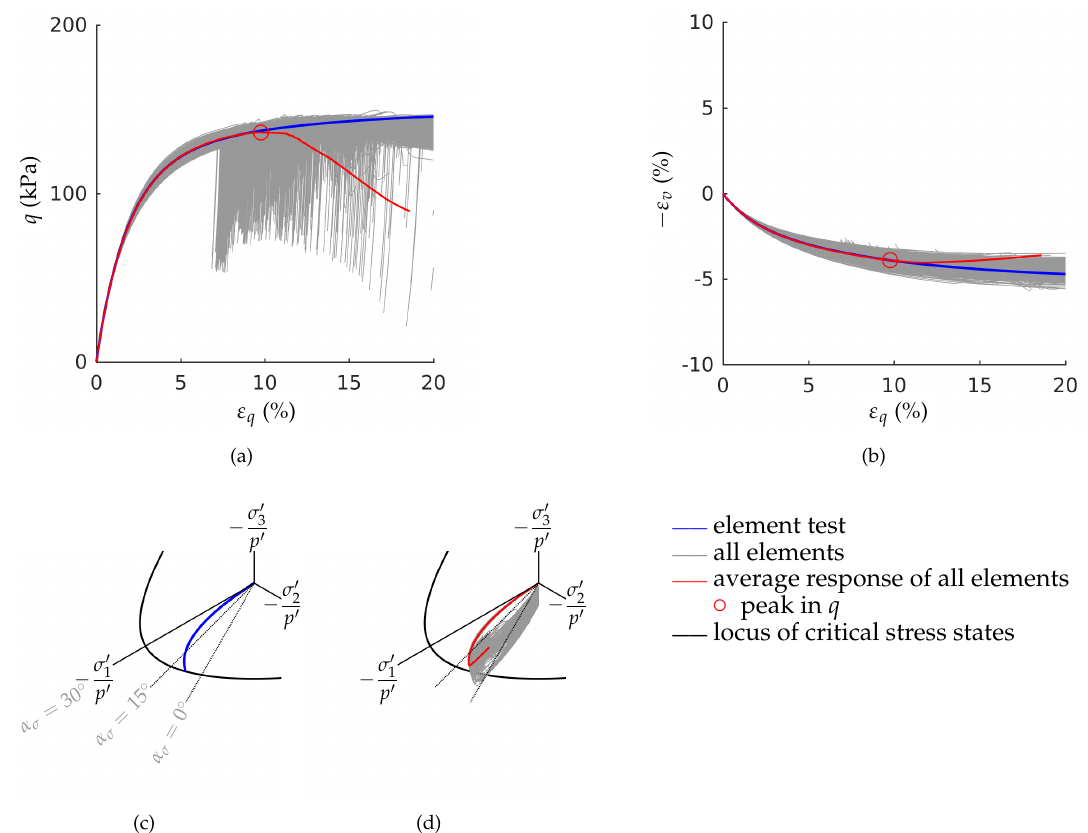
Figure 14. OCR = 1.5: ( a ) Deviatoric strain ε q -deviatoric stress q plot; ( b ) Deviatoric strain ε q -volumetric strain ε v plot; ( c , d ) Stress paths for OCR = 1.5 in the deviatoric plane normalized with the mean effective stress p (cid:48)